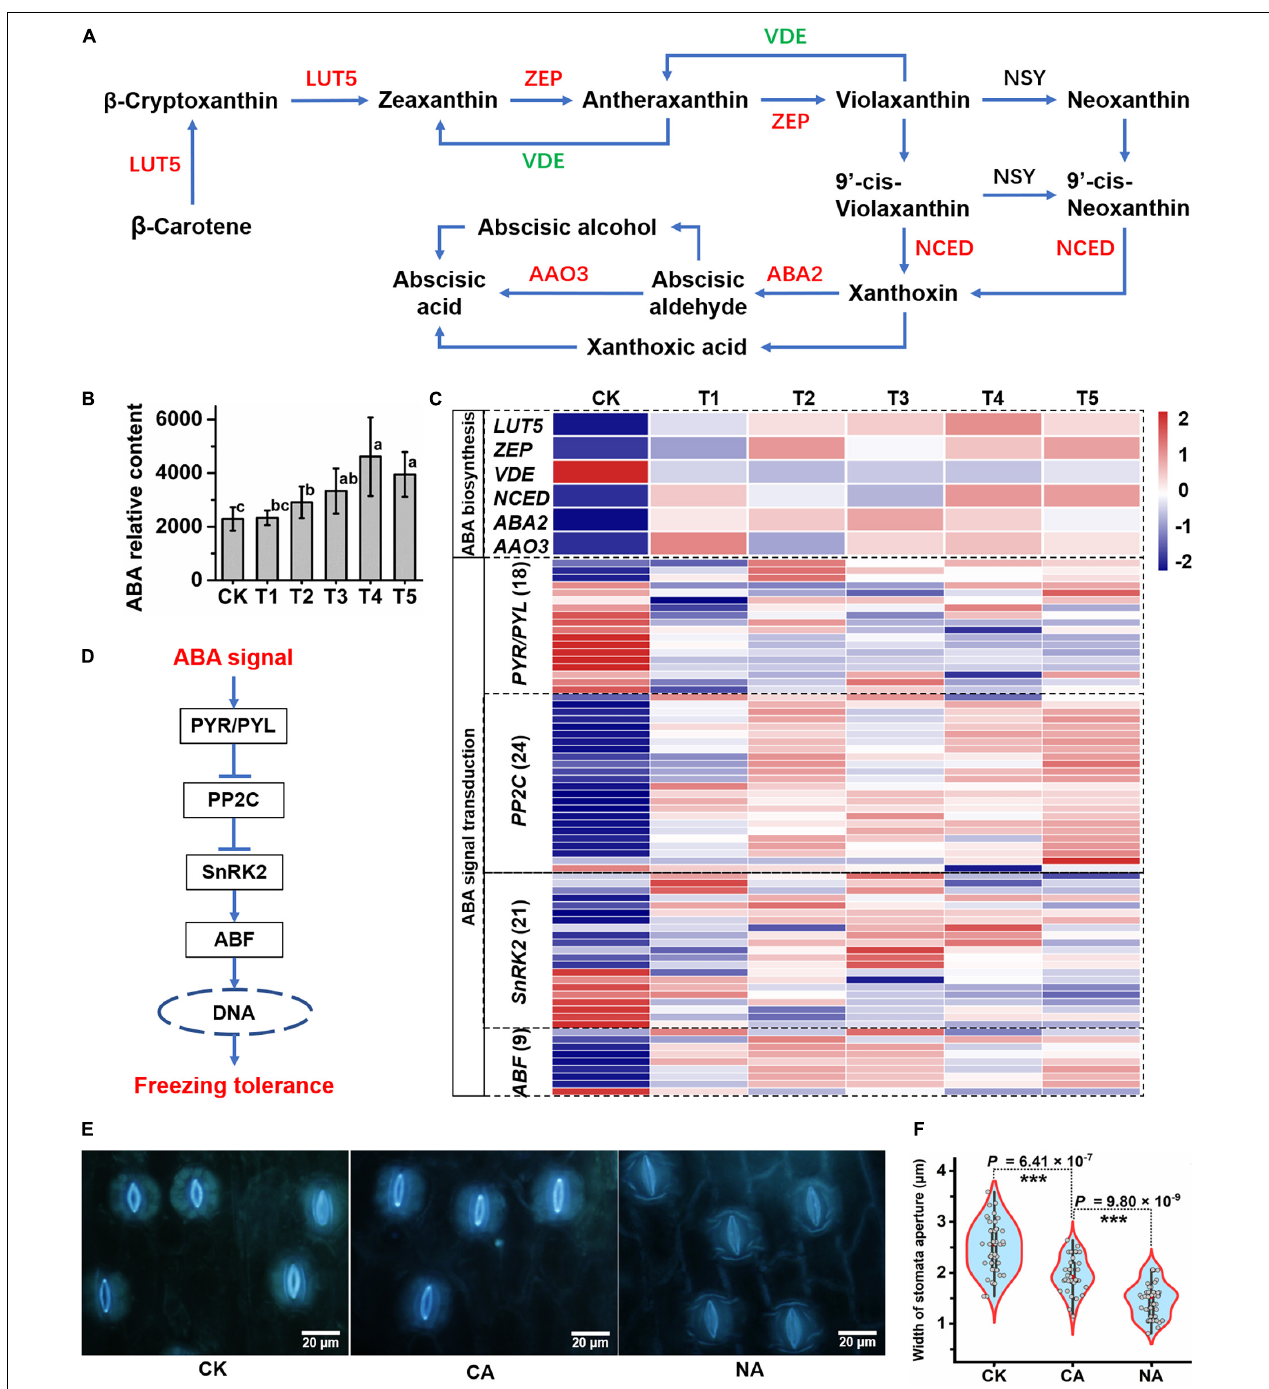
FIGURE 5 | The response of abscisic acid (ABA) biosynthesis to freezing stress. (A) The biosynthesis pathway of ABA was produced according to the KEGG database. LUT5, beta-ring hydroxylase; ZEP, zeaxanthin epoxidase; VDE, violaxanthin de-epoxidase; NCED, 9-cis-epoxycarotenoid dioxygenase; ABA2, xanthoxin dehydrogenase; AAO3, abscisic-aldehyde oxidase. (B) ABA relative content detected by liquid chromatography coupled to electrospray tandem mass spectrometry (LC-MS/MS) in each sample. The letters represent significant differences among the samples; Student’s t -test, p < 0.05. (C) The identified ABA biosynthesis-associated genes and ABA signal transduction genes were hierarchically clustered (Euclidean distance) based on their expression level. (D) The pathway of ABA signaling transduction in plants. PYR1/PYL, pyrabactin resistance 1/PYR1-like; PP2C, type 2C protein-phosphatase; SnRK2, sucrose non-fermenting 1-related protein kinase subfamily 2; ABF, ABA-responsive element binding factors. (E) Stomatal closure and apertures of leaf abaxial epidermis are shown under control and freezing stress conditions. (F) Mean ± SD of 40–60 stomata from the four separate experiments are reported as the width of stomatal aperture. Asterisks represent significant differences in stomatal aperture ( p < 0.001; Student’s t -test) between freezing-treated leaves and the control.